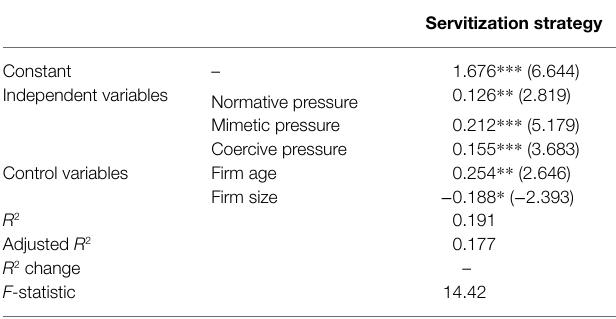
TABLE 9 | Regression analysis of institutional pressures on servitization strategy of